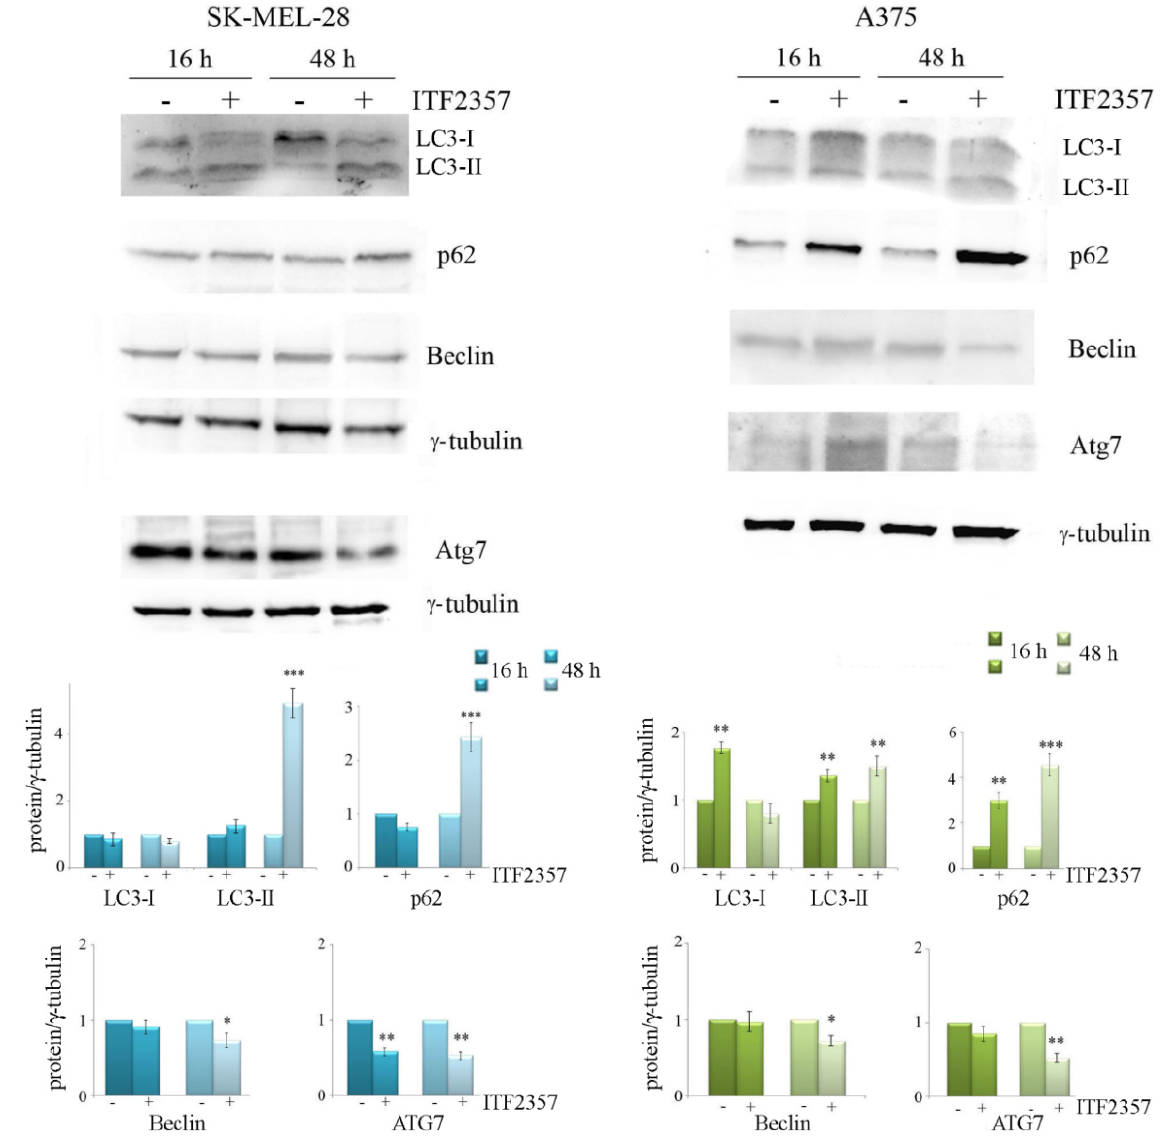
Figure 7. The effects of ITF2357 on autophagic markers. SK-MEL-28 and A375 cells were treated for 16 and 48 h with 5 µ M and 2 µ M ITF2357, respectively. Western blot analysis of autophagic proteins was performed as reported in Materials and Methods. Representative blots of three independent experiments and densitometric analysis are shown. * p < 0.05, ** p < 0.01, *** p < 0.001 with respect to untreated cells.